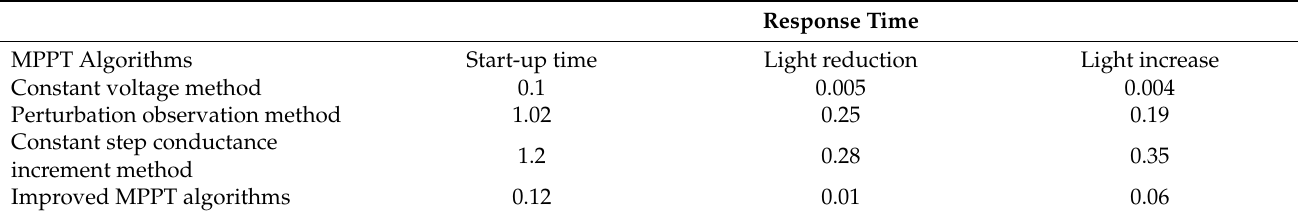
Table 4. Comparison of Dynamic Response Time.